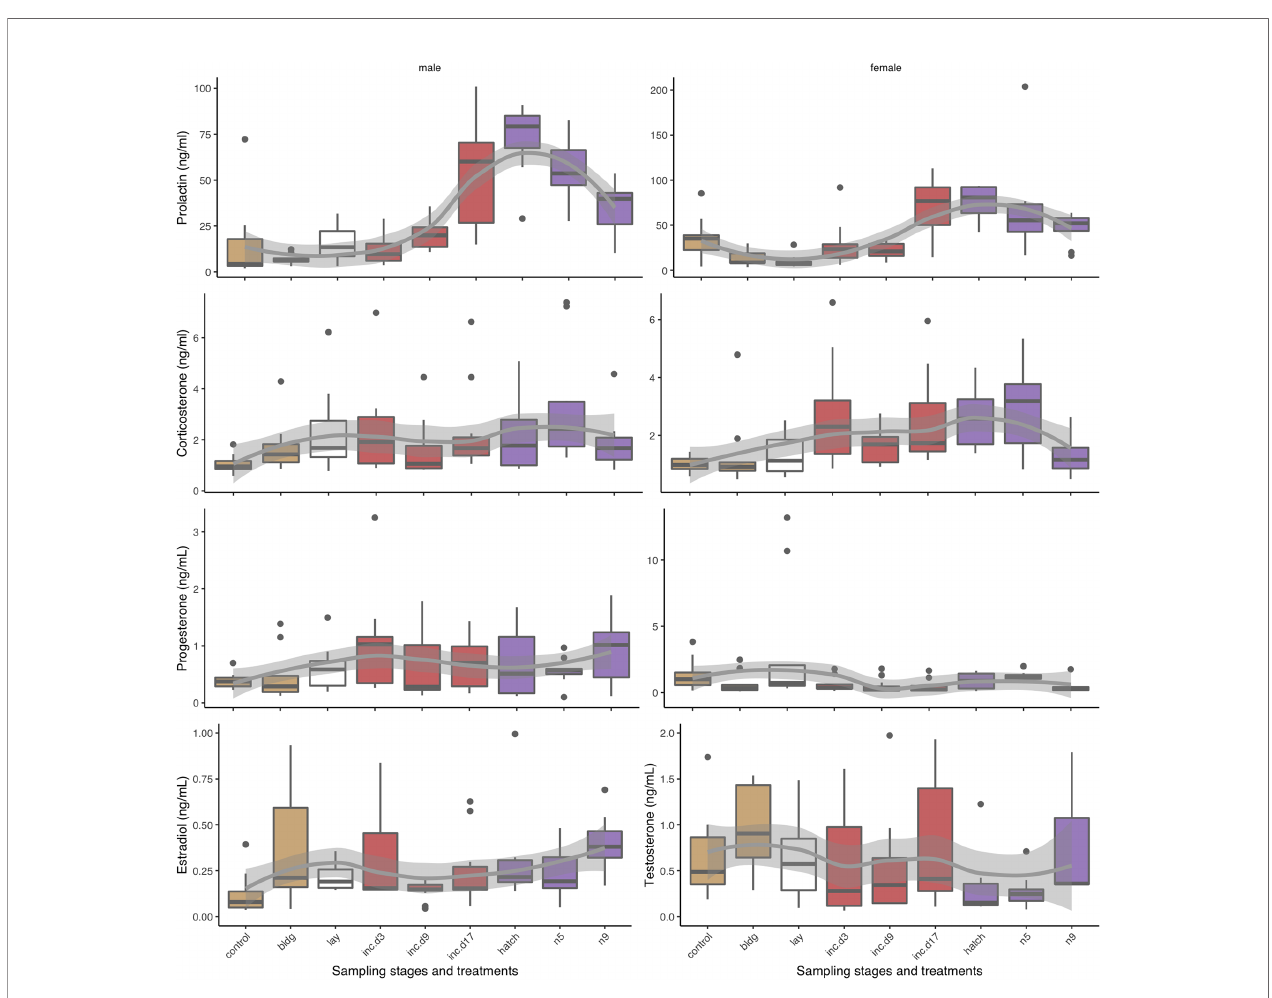
FIGURE 3 | Box plots of circulating hormone levels (ng/mL) of reproduction sampling stages over parental care for corticosterone, progesterone, prolactin, estradiol, and testosterone in males (left) and females (right). Box colors indicate different sub-stages: non-breeding (control) and nest-building (bldg; brown), laying (lay; white), incubation (red, inc.d3=clutch completion, inc.d9=mid-incubation, and inc.d17=late incubation), and the nestling period (purple; hatch, n5=nestling d5, and n9=nestling d9). Boxes represent median and upper and lower quartiles. Whiskers represent the most extreme data point that are within 1.5 of the interquartile